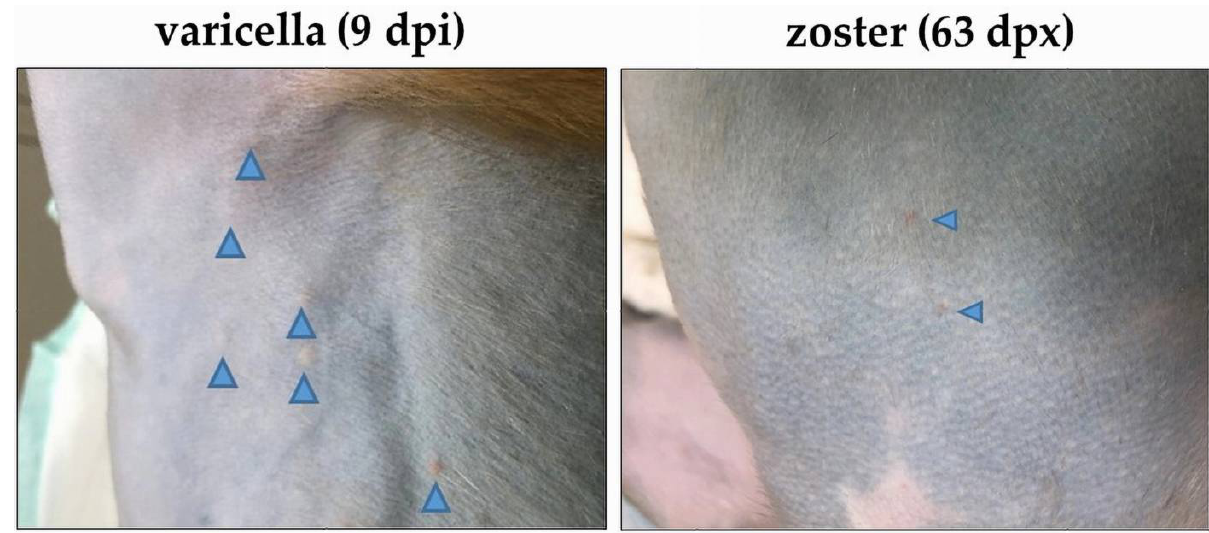
Figure 2. Skin rash after varicella and zoster in monkey LR42 (group 2). Varicella skin rash was seen in the torso nine days after SVV inoculation (dpi; left image ). Zoster skin rash was seen on the torso 63 days after immunosuppression (dpx) with tacrolimus treatment ( right image ). The location of the vesicles is indicated by blue arrowheads.